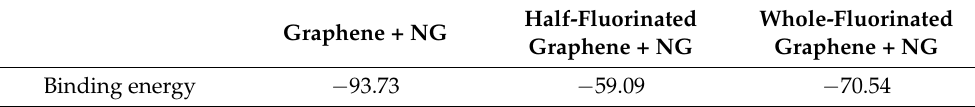
Table 1. The binding energy at wB97M-V/def2-TZVP combined with counterpoise correction.